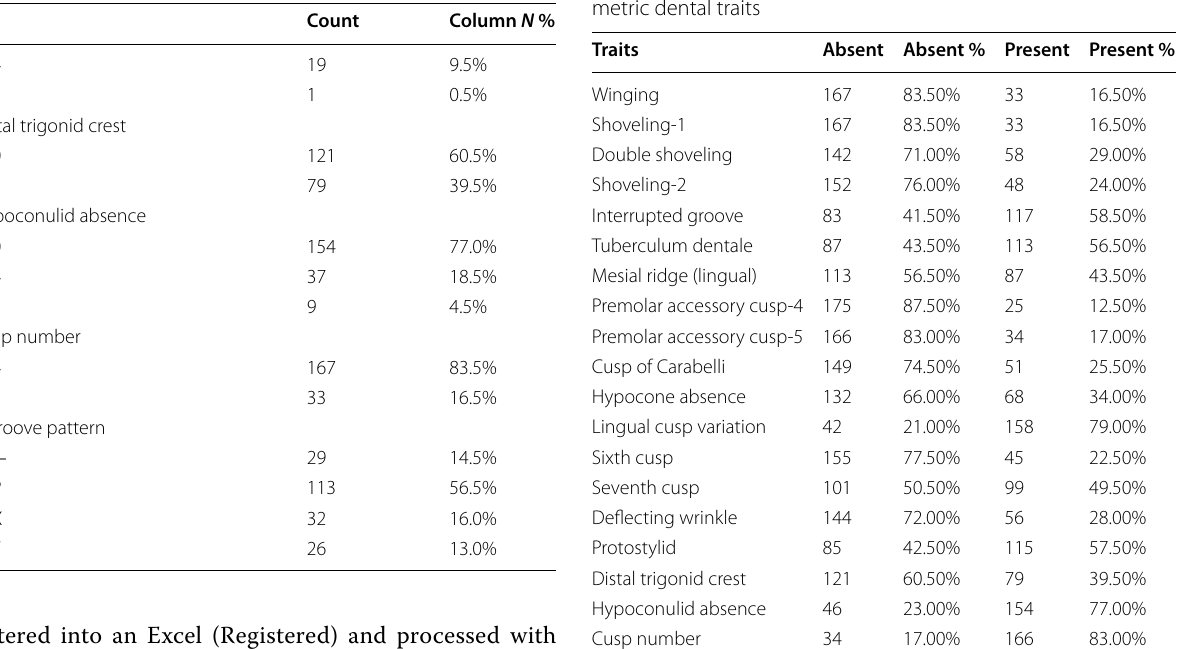
Table 3 Overall dichotomy-based expression of each